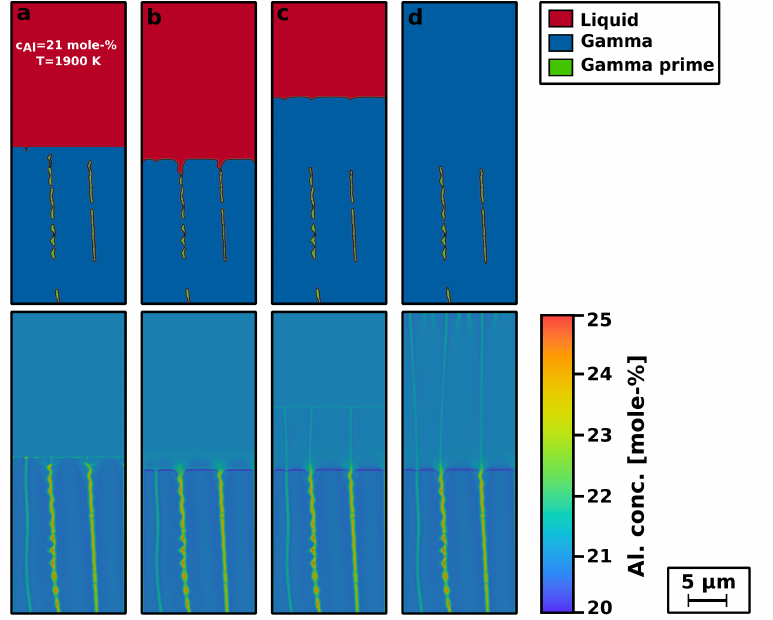
Figure 5. Microstructure evolution and the corresponding Al concentration distribution during the partial remelting inherited by the selective electron beam melting process for different time steps ( a = 0 s, b = 8 · 10 − 5 s, c = 3.75 · 10 − 4 s, d = 0.9 · 10 − 3